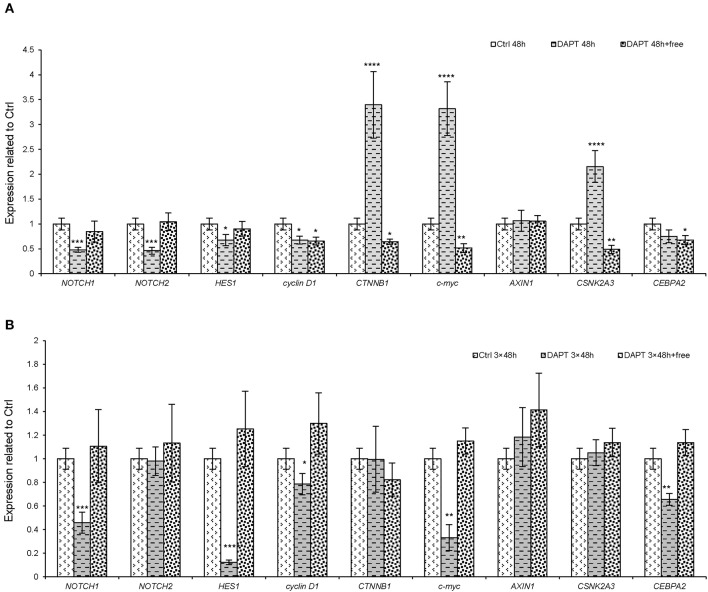
The expression of the downstream genes of both Notch and Wnt pathways and their intermediate genes after DAPT treatment. A375 cells were treated with DAPT in four groups. In the first group, the cells were treated with DAPT for 48 h, representing a short-term treatment. In the second group, initially, the cells, which were treated for 48 h, were washed and cultivated up to 1 week, without any treatment. In the third group, cells were treated for 6 days, representing a long-term treatment. Finally, in the fourth group, the cells that were treated for 6 days were washed and cultivated for an extra 1 week, without any treatment. The expression pattern of important genes in Notch and Wnt pathways and intermediate genes between these two pathways in groups 1 and 2 (A) and groups 3 and 4 (B) were assessed by qRT-PCR. In summary, it seems that the intermediate genes or Wnt pathway could retrieve the inhibitory effect of Notch pathway (n = 3, mean ± SD, *P < 0.05, **P < 0.01, ***P < 0.001, and ****P < 0.0001).